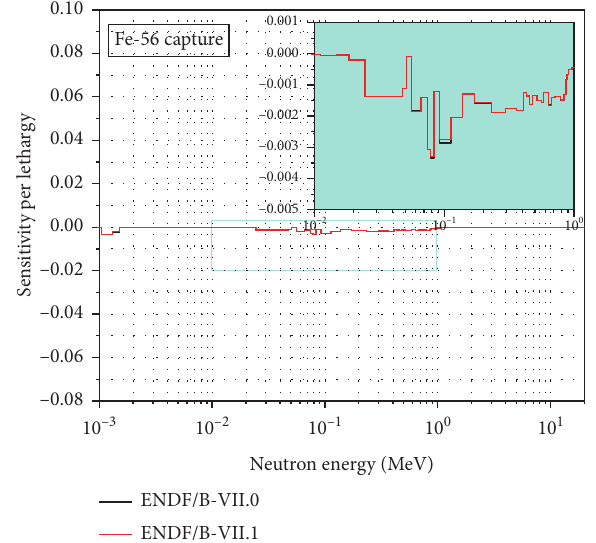
Figure 18: Energy-dependent sensitivities of k cross